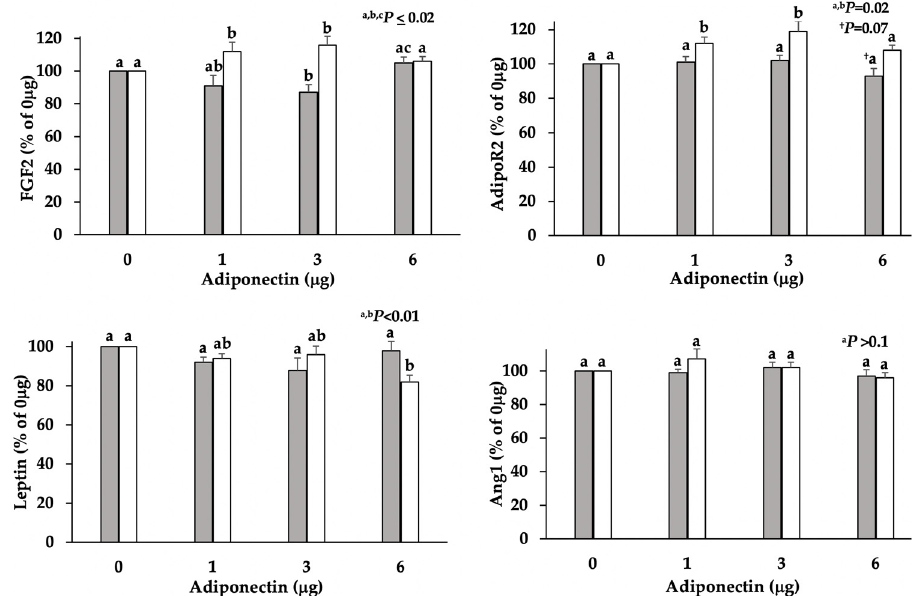
Figure 4. Gene expression of Ang1, FGF2, leptin, and AdipoR2 in D5 (shaded bars; n = 4) and D7 (open bars; n = 5) dispersed lutea cell cultures following 24 h treatment with adiponectin (1, 3, and 6 μ g). Relative quantities of amplicons were transformed to log 10 , normalized with cyclophilin, and expressed as a percentage of the control dose (0 μ g, no adiponectin). a,b,c Different superscripts iden- tify means that significantly differ ( p < 0.05) within day relative to dose of adiponectin. † Superscript identifies means that tended ( p = 0.07) to differ relative to dose of adiponectin within day.